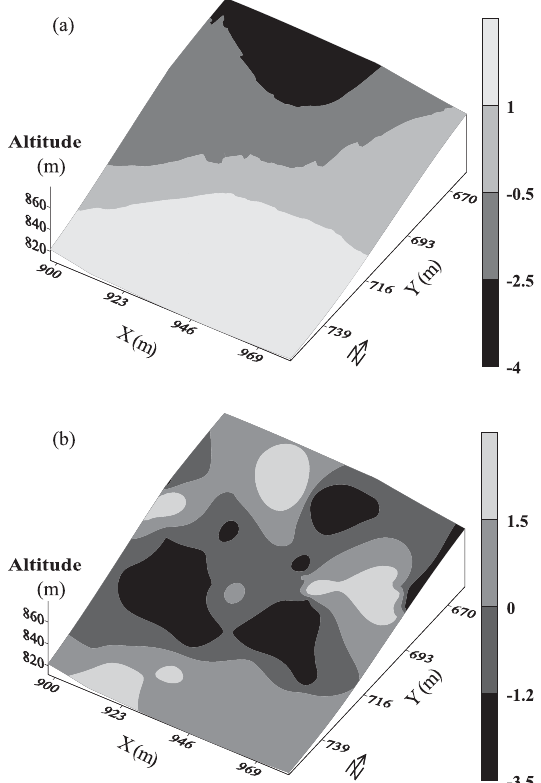
Figura 7. Mapa do primeiro (fator acidez do solo) (a) e do segundo (fator teor de matéria orgânica do solo) (b) componente principal. Os valores incluídos no eixo Z correspondem à altitude do terreno e os valores apresentados na legenda correspondem aos escores dos componentes